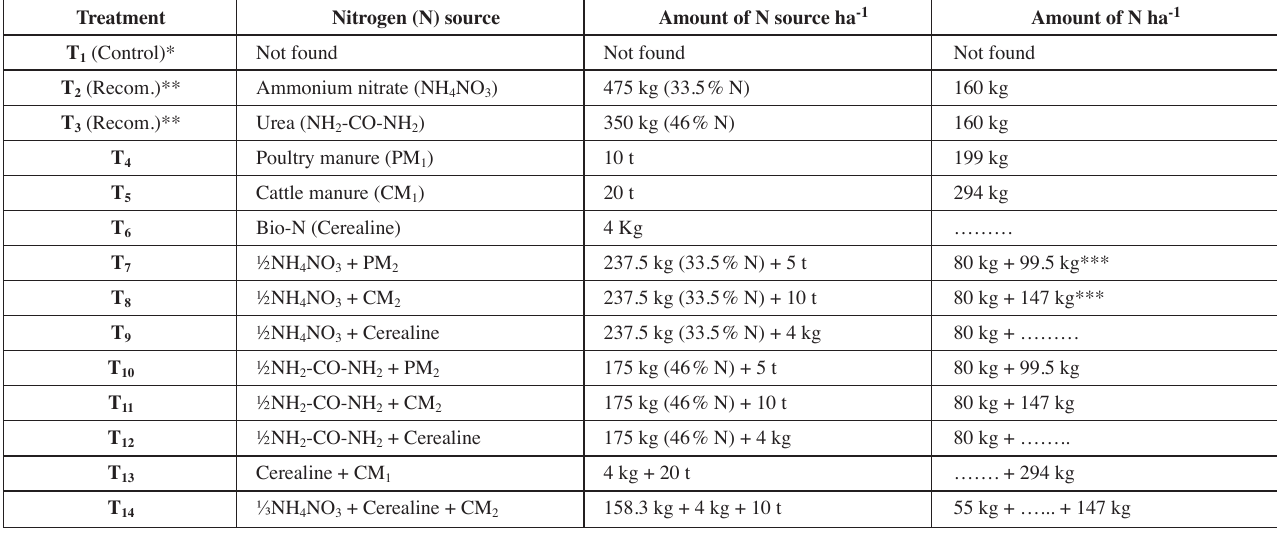
Tab. 2: Components of the 14 treatments used in the present experiment